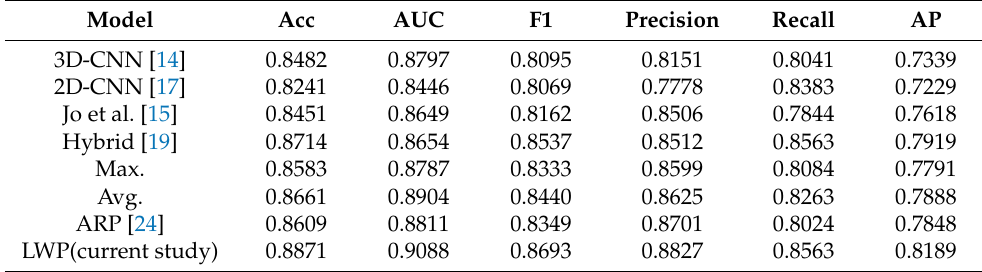
Table 4. The performance results of different 2D and 3D CNN models on PET image.